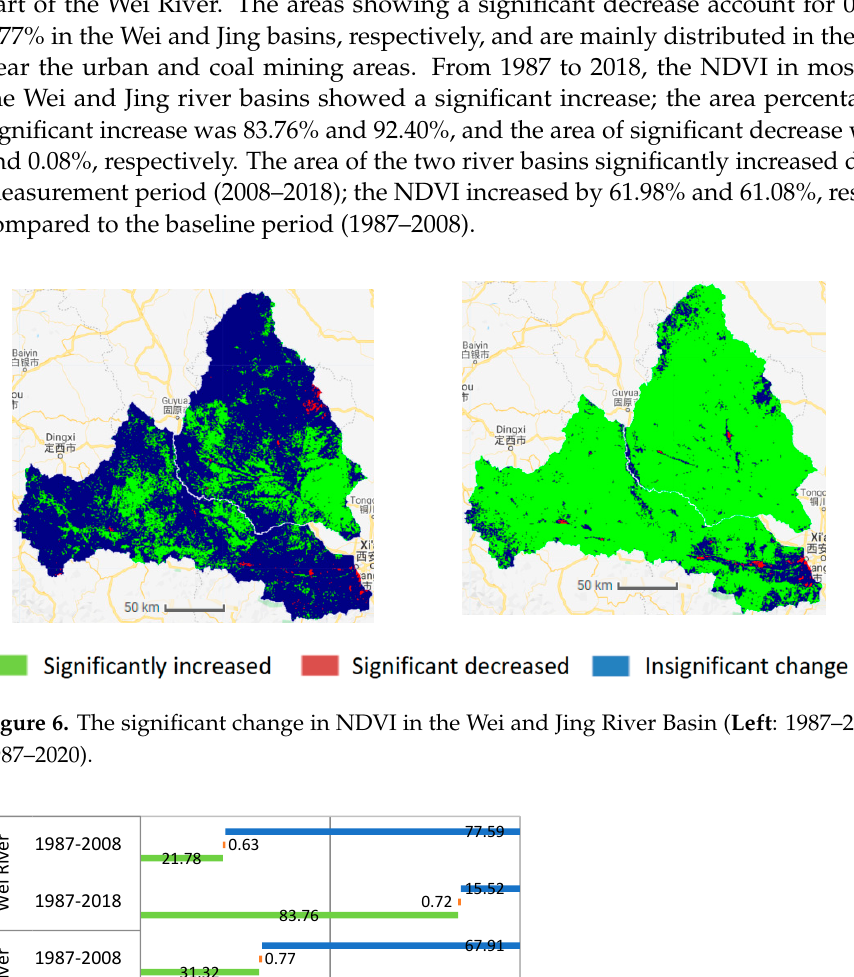
Figure 5. Spatial distribution of NDVI (mean value in growth season) from 1987 to 2018 in Wei and Jing River Basin.